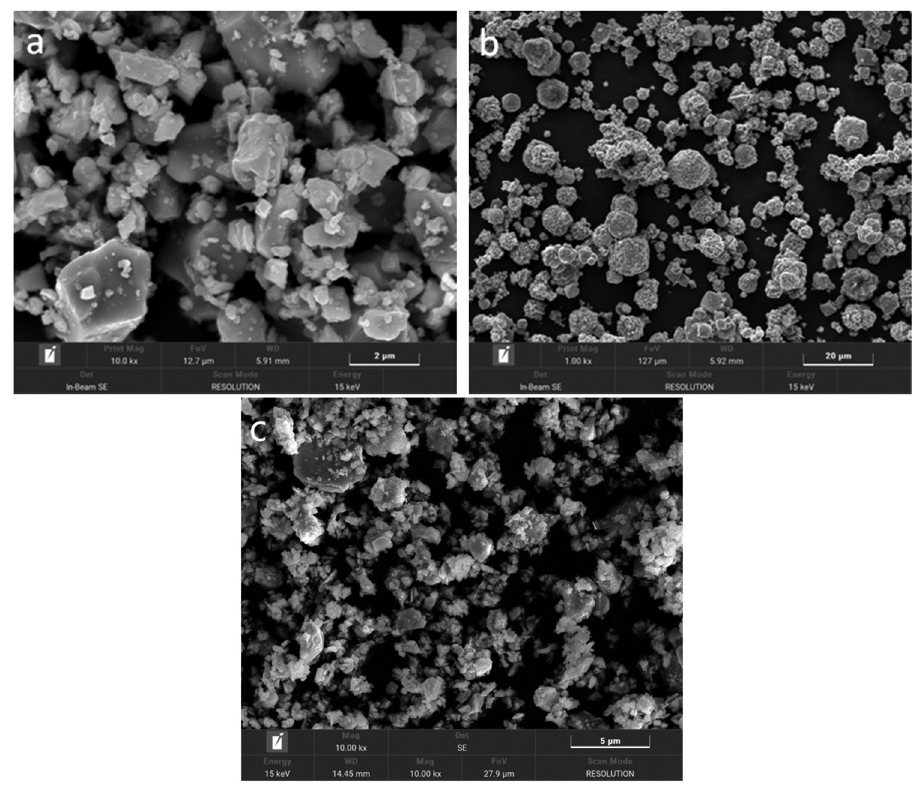
Figure 1: Morphology of the raw material powders: ( a ) NbC, ( b ) Ni, and ( c ) NbC – 12Ni after ball